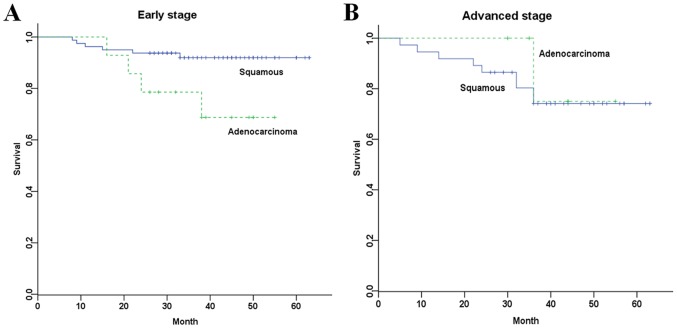
Kaplan-Meier analysis of progression-free survival.(A) PFS of young patients with early FIGO stage stratified by histological type (log-rank test P = 0.024). (B) PFS of young patients with advanced FIGO stage stratified by histological type (log-rank test P = 0.584).